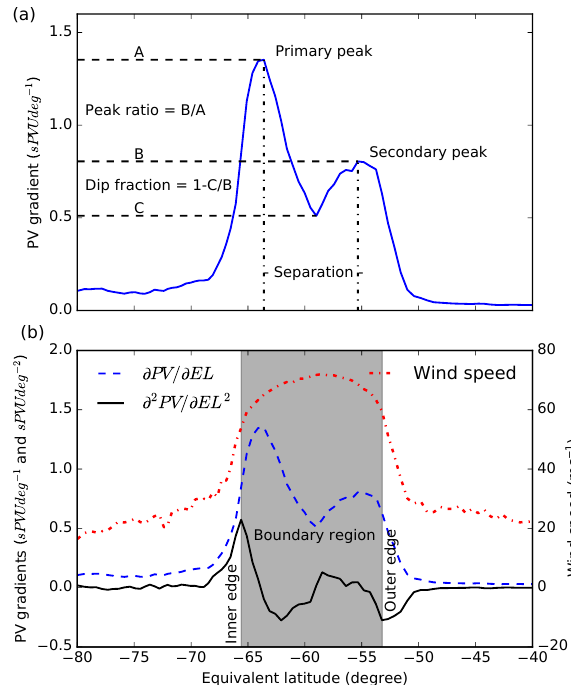
Figure 1. Example of (a) the calculation of the peak ratio, dip fraction and separation from a meridional profile of PV gradient ( ∂ PV /∂ EL) and (b) the calculation of inner and outer edges of the vortex boundary region from ∂ 2 PV /∂ EL 2 (sPVU ◦− 2 ), with wind speed (ms − 1 ) and ∂ PV /∂ EL (sPVU ◦− 1 ) also shown for ref- erence. This example is a profile at 530K on 1 September 2007 from